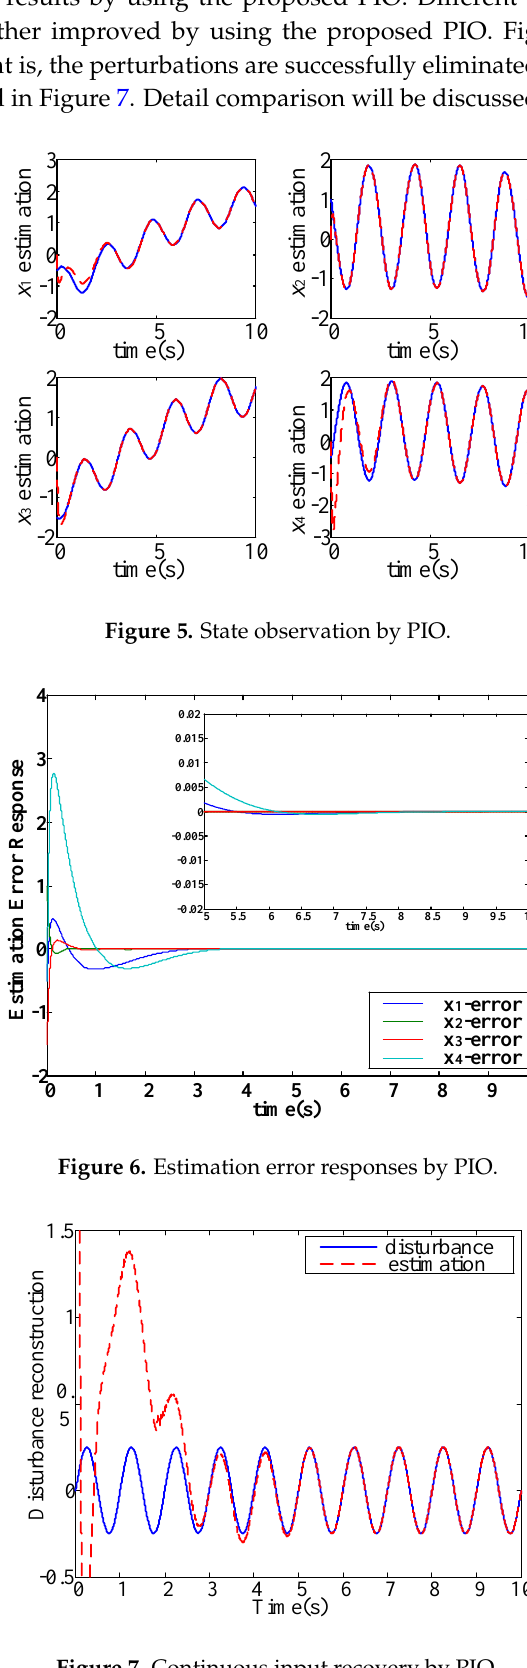
Figure 7. Continuous input recovery by PIO.